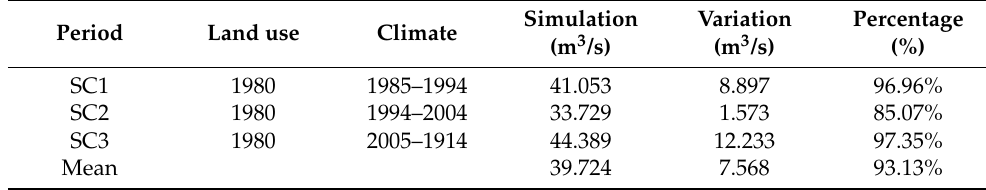
Table 7. Contribution of climate change to surface runoff change.